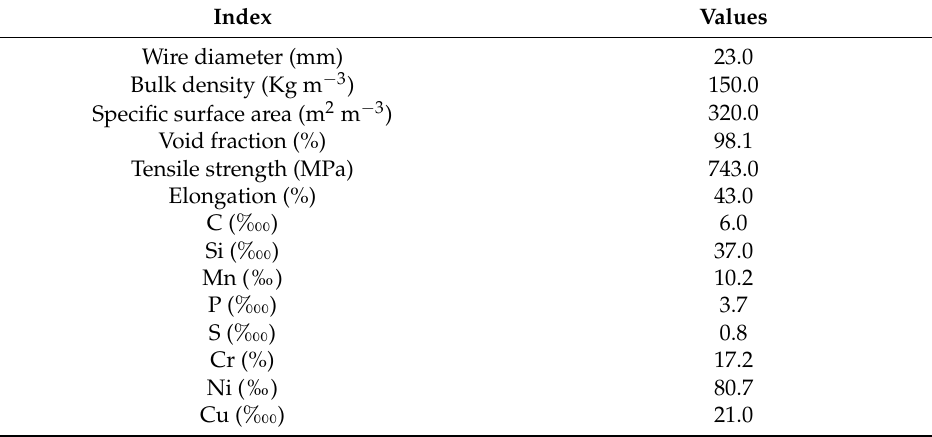
Table 2. The quality inspection report of